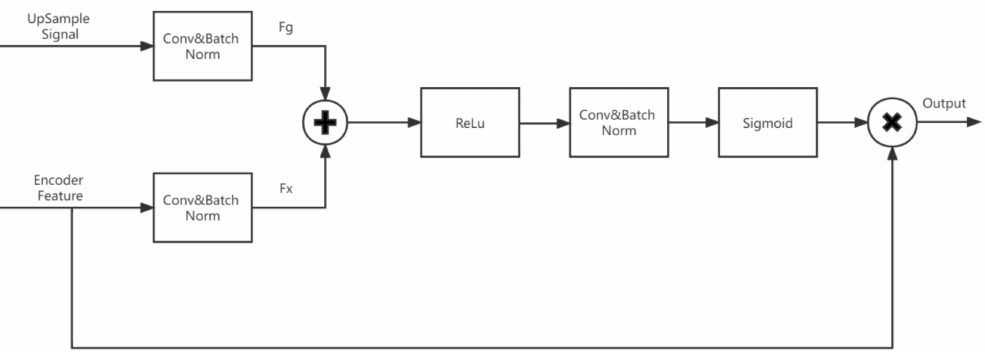
Figure 6. Schematic diagram of the structure of the attention gate. Encoder features are scaled with attention coefficients calculated in the attention